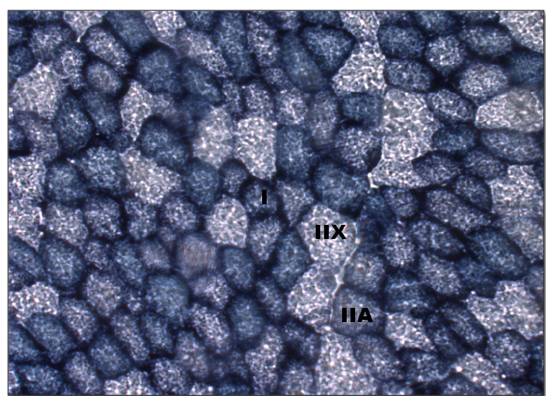
Figura 3. Fotomicrografia de corte transversal do músculo Glúteo Médio do equino de número 5, utilizando-se a técnica de enzimo-histoquímica para marcação da atividade da enzima succinato desidrogenase, onde as fibras do tipo I são coradas de azul escuro, as do tipo IIA são coradas de azul intermediário e as fibras do tipo IIX coram-se de azul claro. Obj.